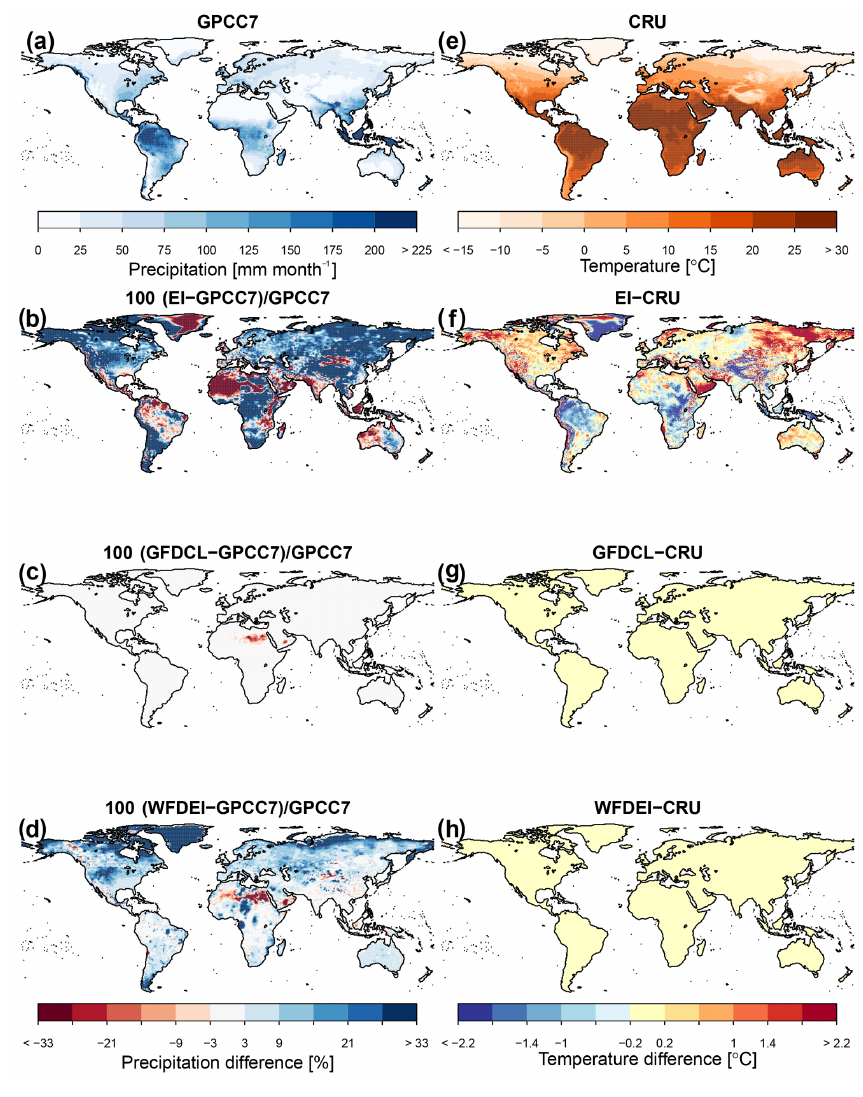
Figure 2. Climatology of (a) precipitation from GPCC7 and (e) temperature for CRU. Relative percentage difference in climatological precipitation from GPCC7 for (b) EI, (c) GFDCL and (d) WFDEI. Absolute difference in climatological temperature from CRU for (f) EI, (g) GFDCL and (h) WFDEI.